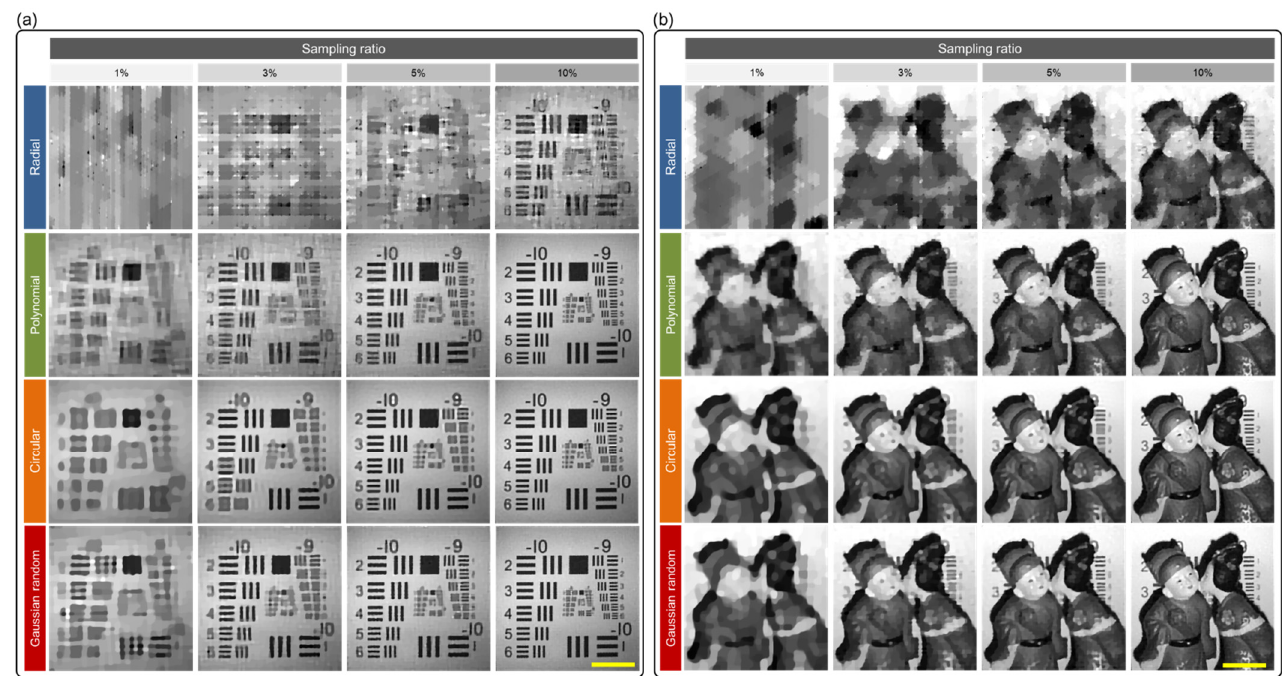
Figure 6. Experiment results for ( a ) USAF-1951 resolution test chart pattern and ( b ) a pair of china dolls. DMD refreshing rate is 50 Hz. Scale bars = 5 cm.